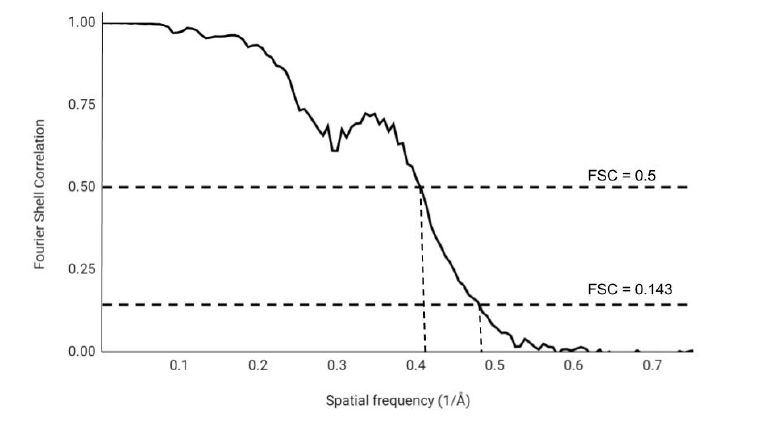
Figure 1. A typical FSC curve with the thresholds 0.5 and 0.143